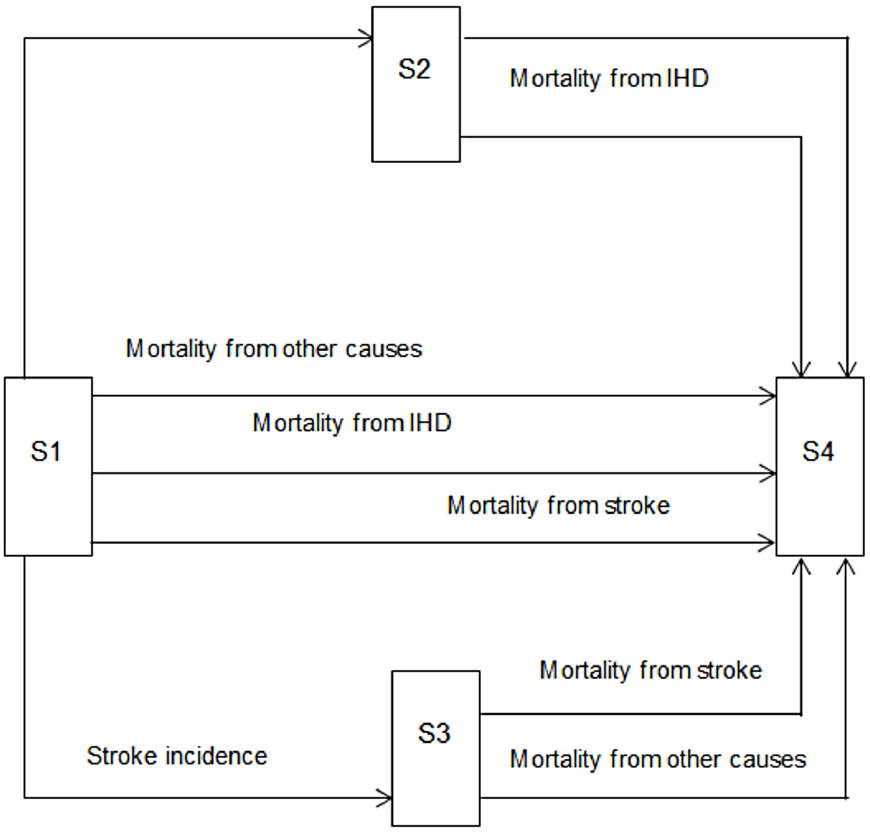
Fig 2. Overviewof the epidemiological Markov model. Health states: S1 = No history of CVD (i.e. IHD or stroke), S2 = Histroy of IHD, S3 = History of stroke and S4 = Dead.